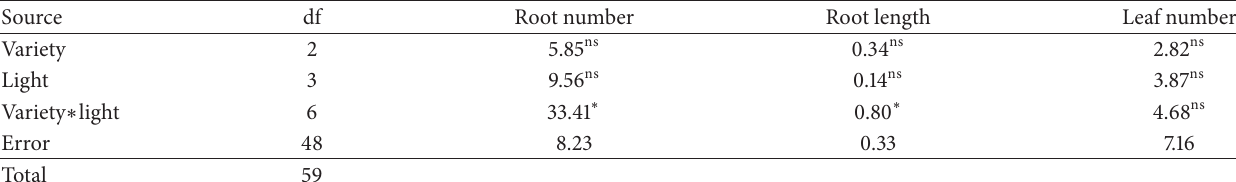
Table 12: Mean square from analysis of variance for light treatments on day 14.